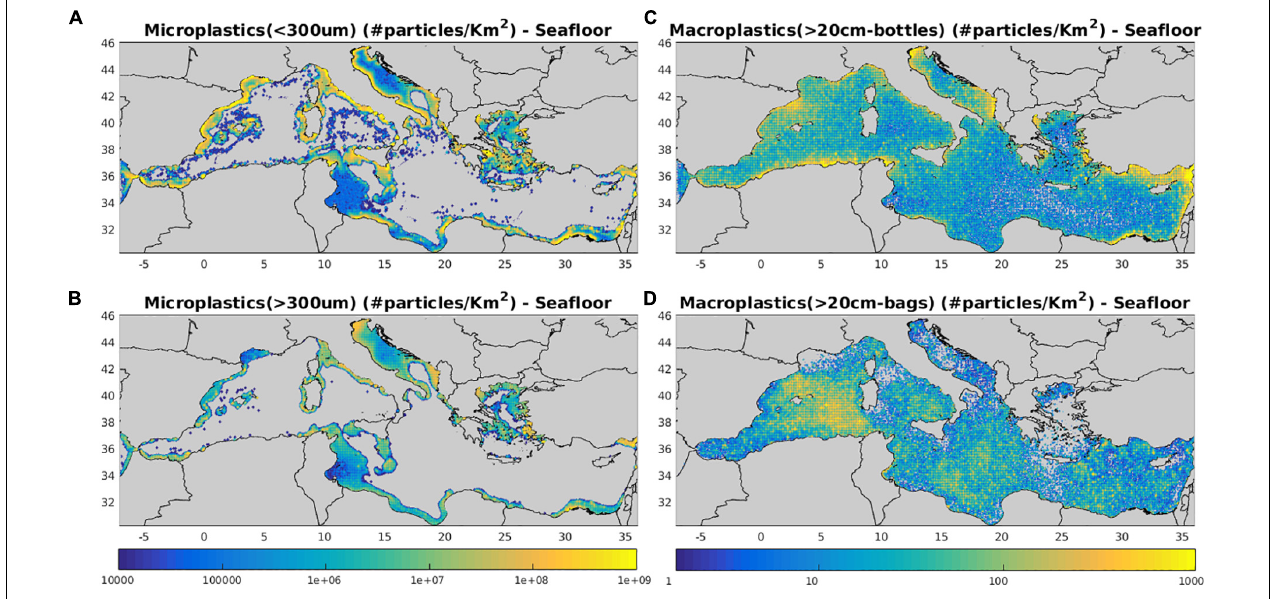
FIGURE 12 | Mean (2010–2017) model simulated (A) microplastics < 300 µ m, (B) microplastics > 300 µ m, (C) macroplastics > 20 cm bottles and (D) macroplastics > 20 cm bags seafloor concentration (#/Km 2 ).